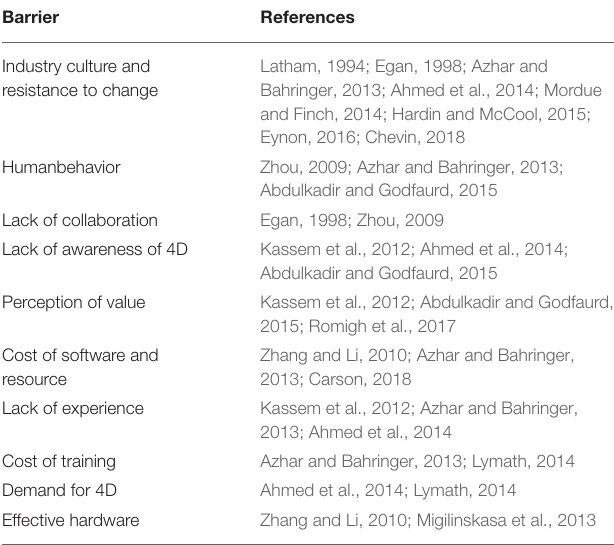
TABLE 2 | Summary of the barriers of 4D in relation to health and safety management.